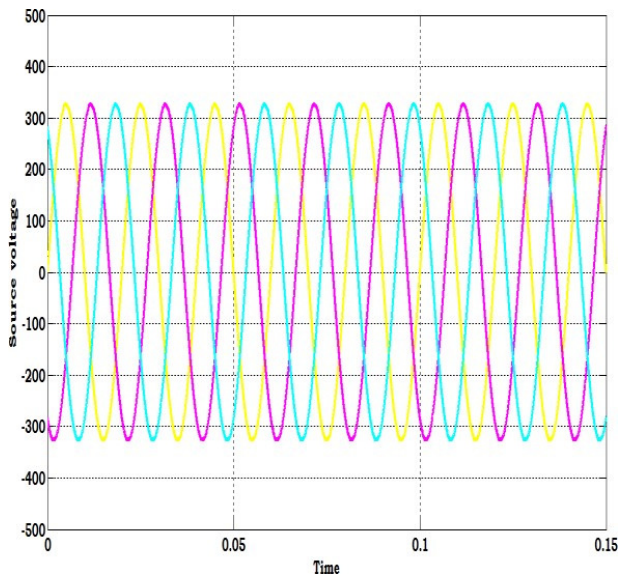
Figure 4. Waveform of Voltage at